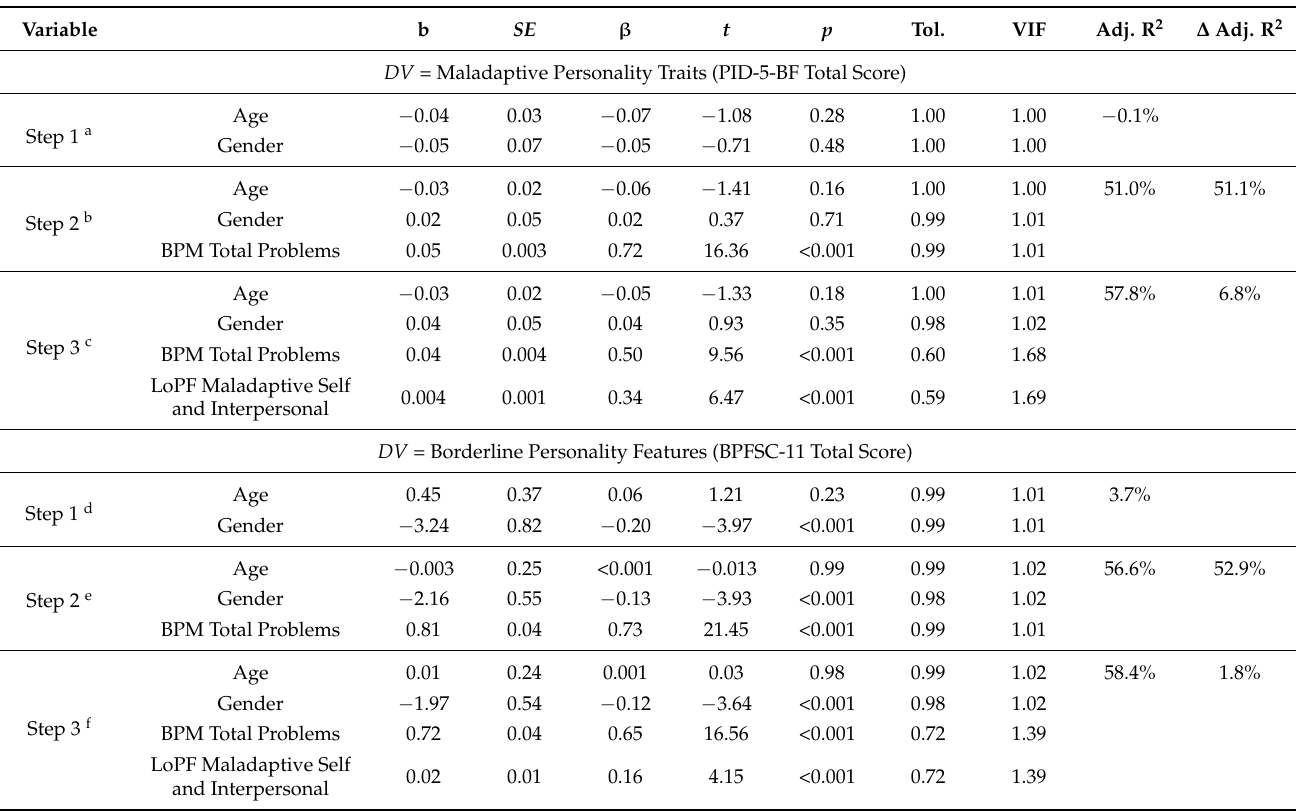
Table 3. Hierarchical regression models testing the incremental validity of LoPF maladaptive self- and interpersonal